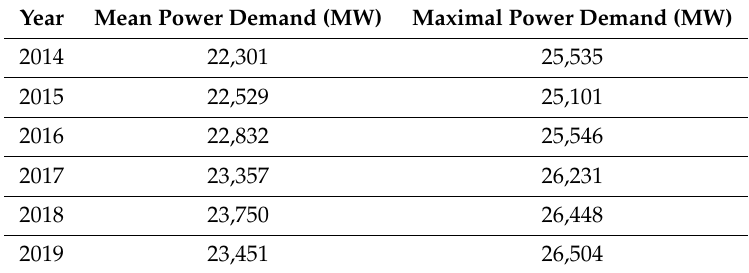
Figure 1. Mean and maximal power demands in MW, for every year between 1989 and 2019 in the Polish Power System (PPS) [18]. Table 1. The mean and maximal power demands in MW for 2014–2019 in Polish Power System.